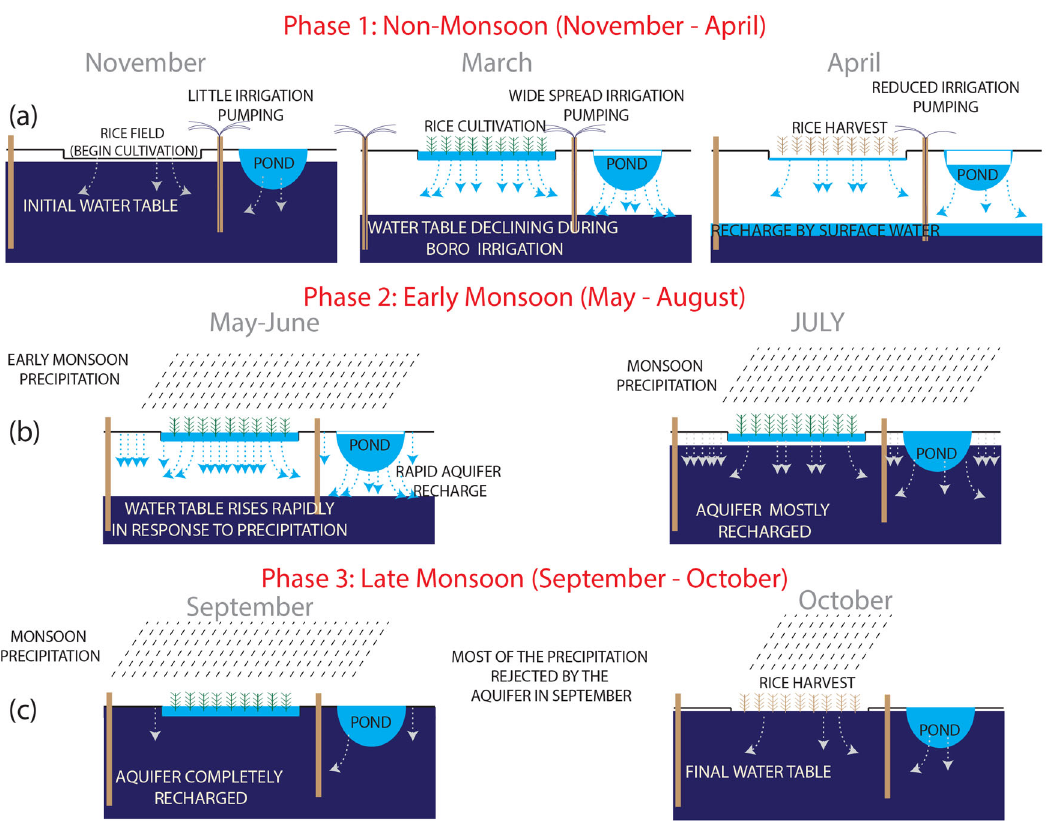
Fig. 9 Conceptual recharge model for a shallow (<50 m deep) aquifer in the Bengal Basin from ponds and rice fi elds. a In phase 1 (November – April), large amounts of groundwater are extracted for rice irrigation leading to a lowering of the water table. During the same period, the aquifers are also recharged due to the lowering of the water table and higher head of ponds and rice fi elds. b In phase 2 (May – August), the shallow groundwater starts to recharge rapidly in response to the incoming monsoon precipitation, and by July, the aquifer is mostly recharged. c During the early part of phase 3 (September), the aquifers are completely replenished, and most of the subsequent monsoon precipitation is rejected by the aquifer. By the end of phase 3 (October), the monsoon has fi nished, and the fl ood waters have receded, beginning a period of groundwater abstraction for irrigation. The blue and gray arrows illustrate the recharge paths. For simplicity, the exchange between river and groundwater has been excluded from this fi